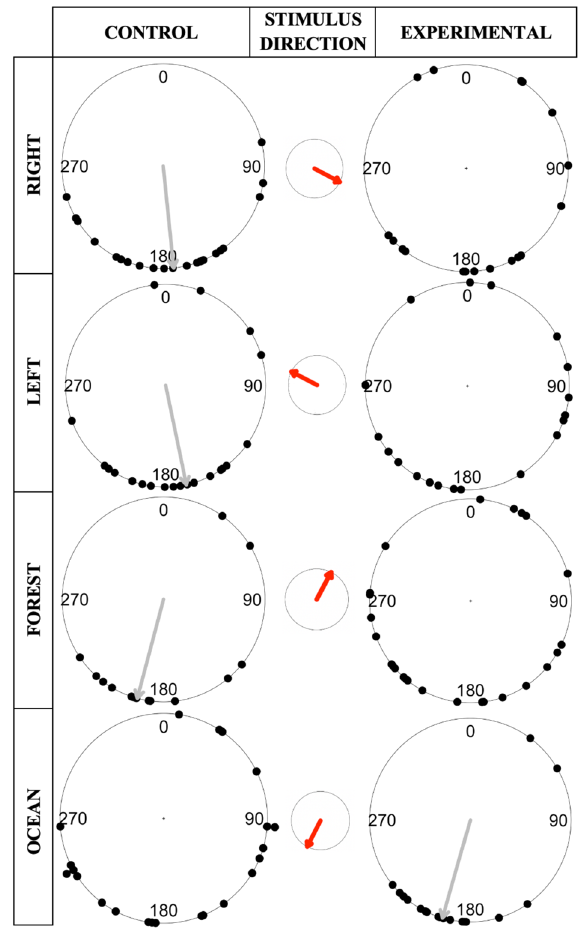
Figure 5. Circular plots of the directions handled crabs moved in control vs experimental conditions. Plots display the compass bearing direction of individual focal crabs (each black dot represents a single crab). Data are separated by condition (control or experimental) and stimulus direction (left, right, forest, or ocean). The red arrow in the center circle displays the stimulus direction. Grey arrows show mean/median directions when a significant orientation existed (see Table 2).